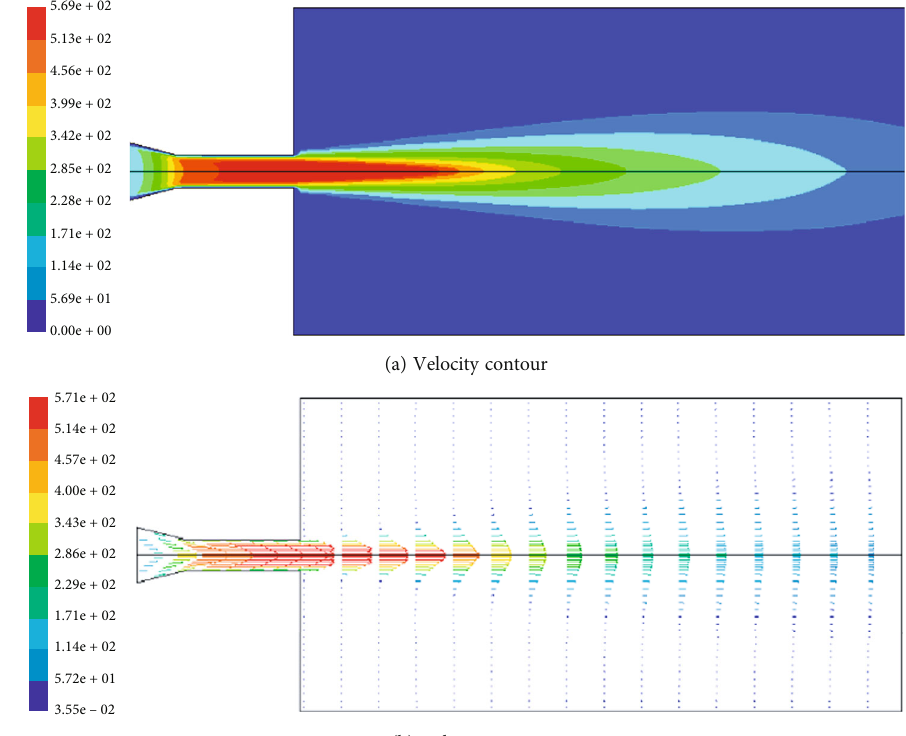
Figure 2: Velocity distribution of the water jet (m/s).